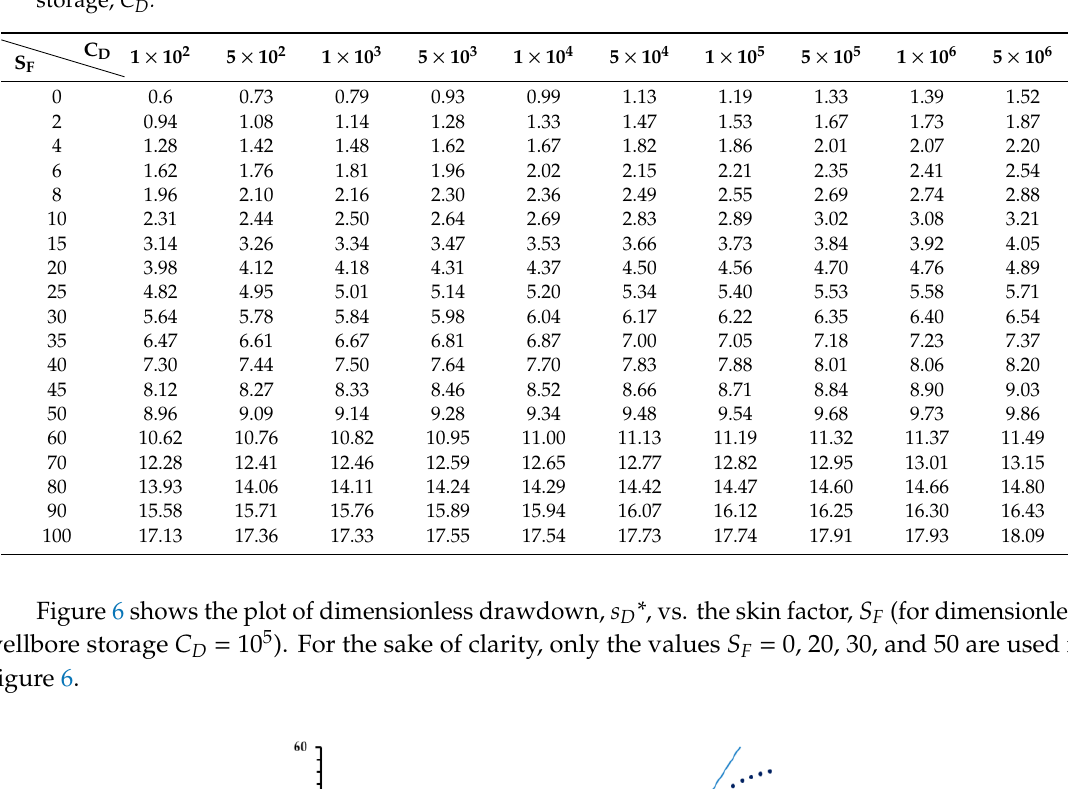
Figure 7. Dependence s D * vs. skin factor, S F , for values of C D (1 × 10 2 , 5 × 10 2 , 1 × 10 3 , 5 × 10 3 , and 1 × 10 4 ) and S F (0, 2, 4, 6, 8, and 10).